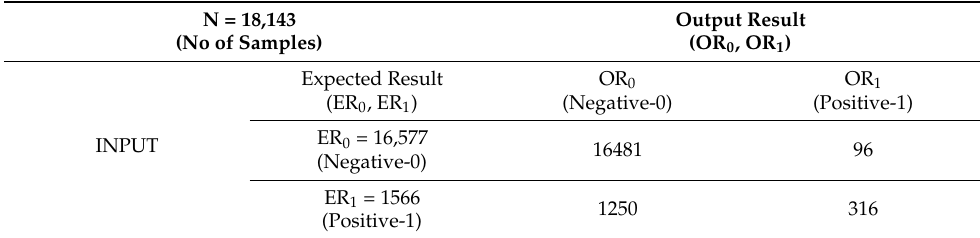
Table 8. KNN training results.